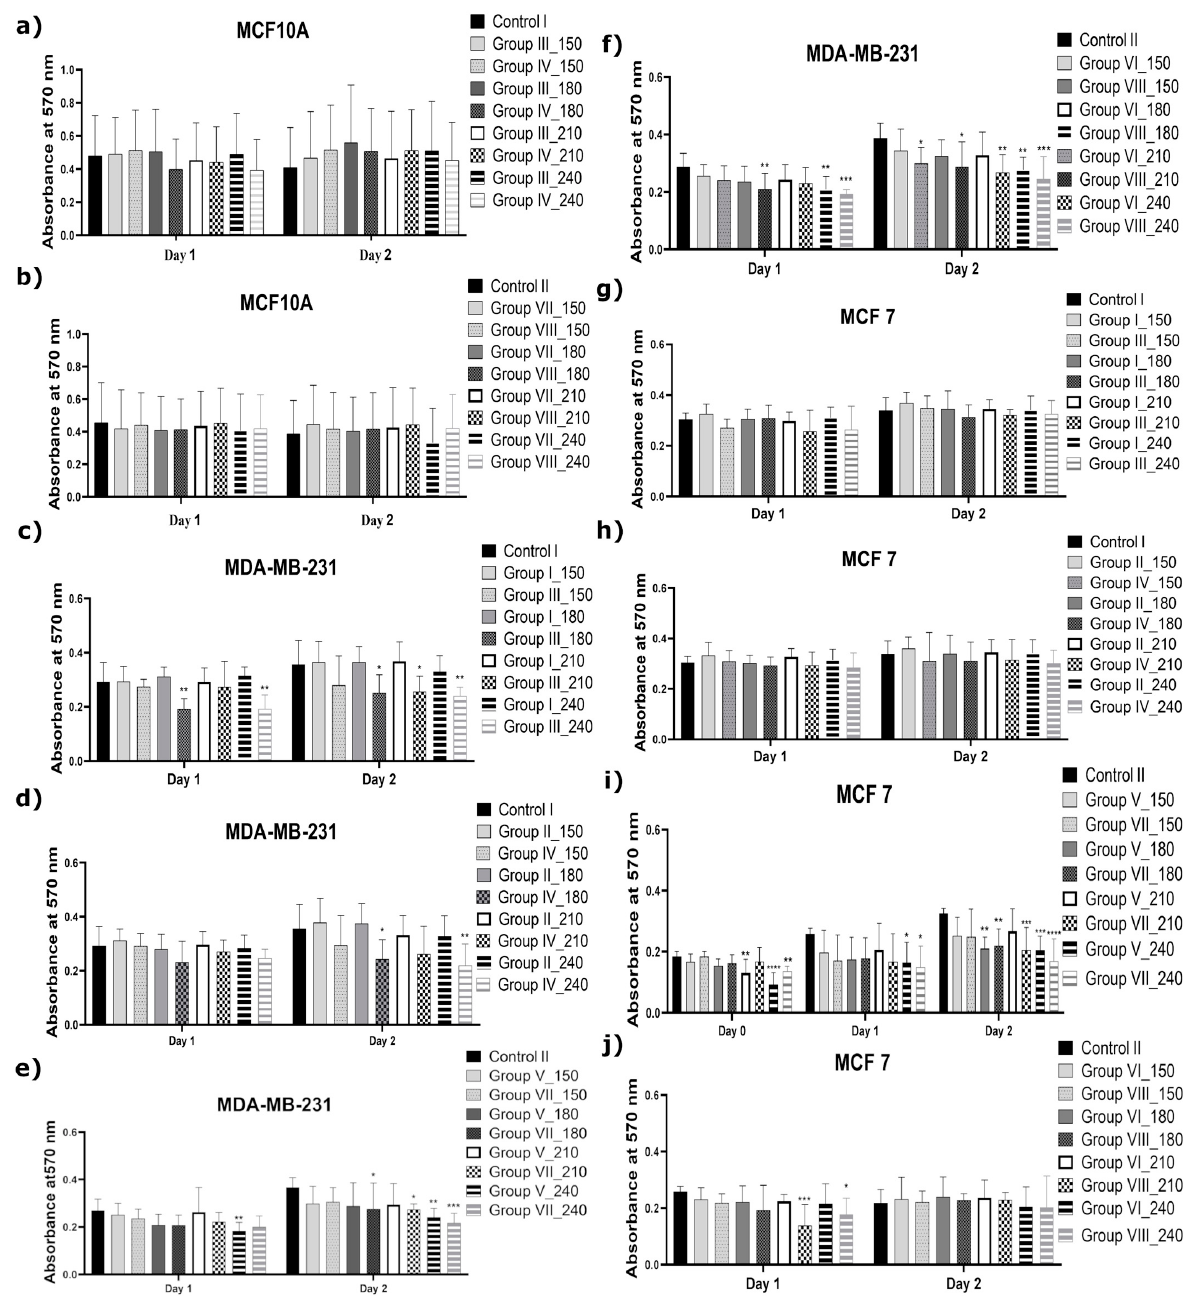
Figure 2. The comparison of the impact of the addition of FBS after the production of the CAPP-activated medium on the proliferative ability of human metastatic breast cancer (MDA-MB-231), human non-metastatic breast cancer (MCF7), and non-cancerous human normal (MCF10A) cell lines. The cell lines were incubated in the CAPP-activated medium obtained by CAPP treatment for 150 s, 180 s, 210 s, or 240 s. ( a , c , g ) The MCF10A, MDA-MB-231, and MCF7 cell lines treated with 3.0 mL of the CAPP-activated DMEM with the FBS (Group I) or without the FBS (Group III); ( a , d , h ) the MCF10A, MDA-MB-231, and MCF7 cell lines treated with 1.5 mL of the CAPP-activated DMEM with the FBS (Group II) or without the FBS (Group IV); ( b , e , i ) the MDA-MB-231 and MCF7 cell lines treated with 3.0 mL of the CAPP-activated Opti-MEM with the FBS (Group V) or without the FBS (Group VII); ( b , f , j ) the MDA-MB-231 and MCF7 cell lines treated with 1.5 mL of the CAPP-activated Opti-MEM with the FBS (Group VI) or without the FBS (Group VIII). A culture medium that was not treated with CAPP was used as control (Controls I and II). Data are means ± SD values for three independent experiments conducted in triplicates. The statistical calculation was performed by the comparison of all the investigated groups versus the control using one-way ANOVA with the Dunnett’s post hoc test (* p < 0.013; ** p < 0.0014; *** p < 0.0002; **** p <